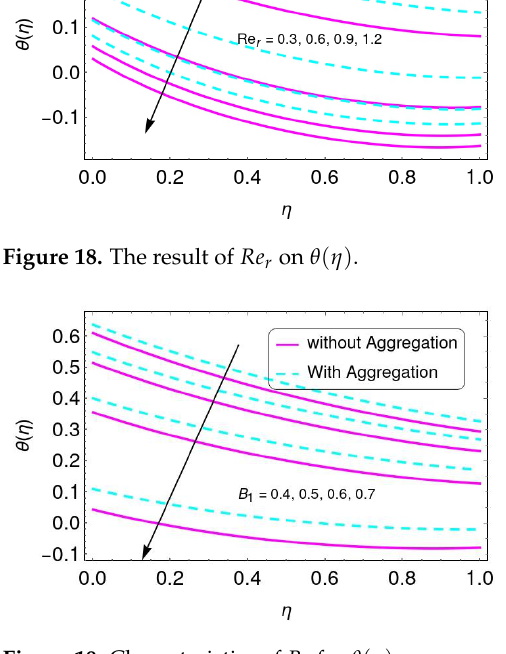
Figure 19. Characteristics of B 1 for θ ( η ) .